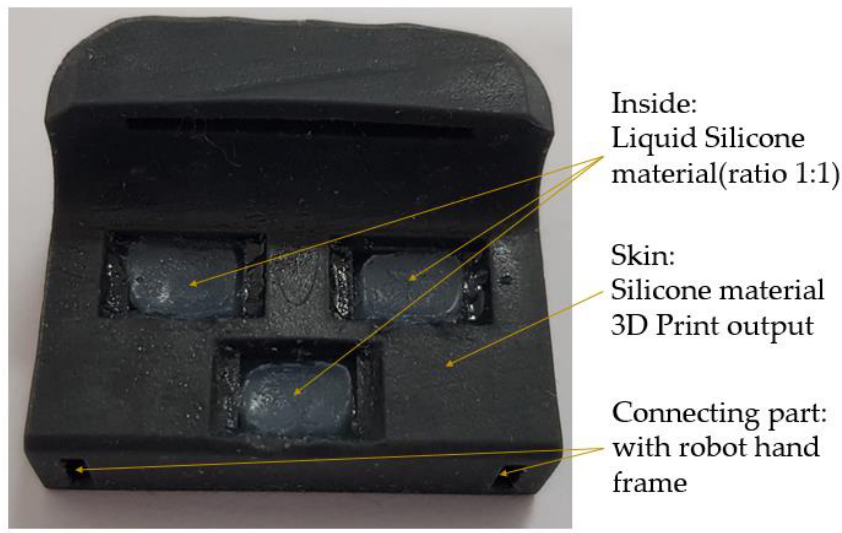
Figure 2. Configuration of finger skin.